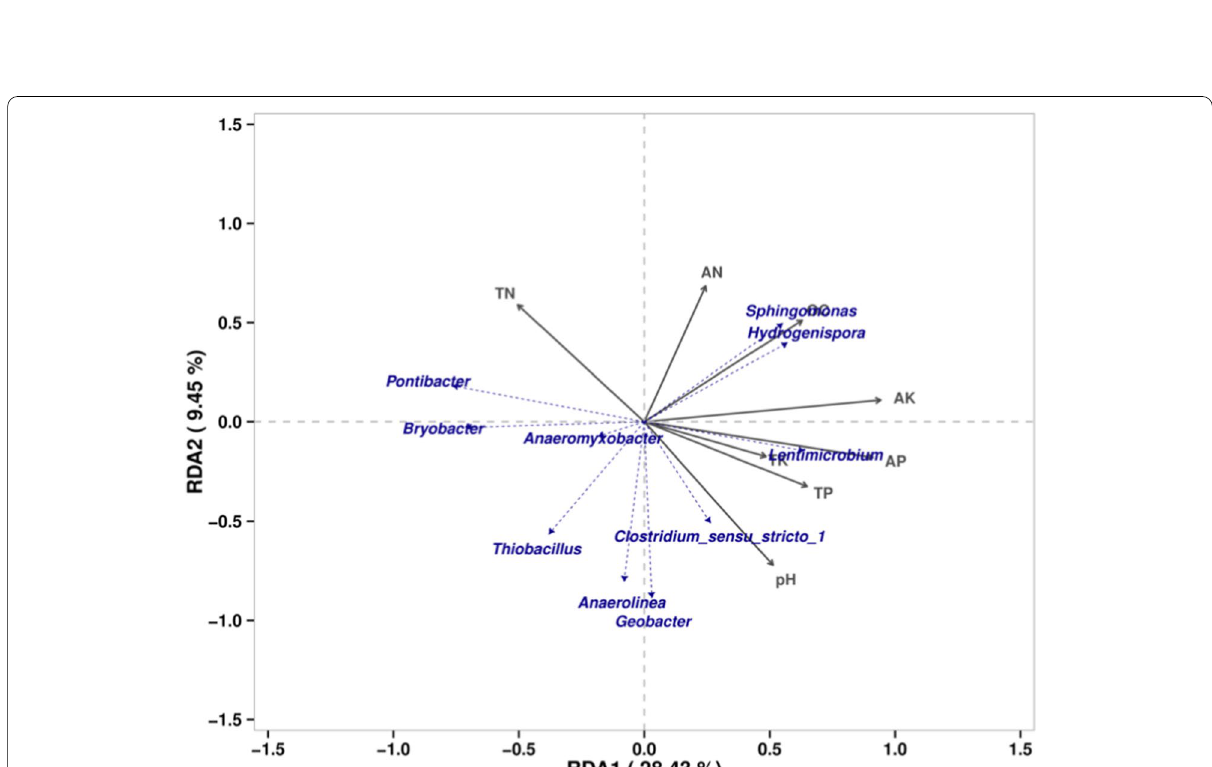
Fig. 4 Redundancy analysis of bacteria communities and environmental factors of soil. TP, total phosphorus; AK, available potassium; OC, organic matter; AN, available nitrogen; TN, total nitrogen; TK, total potassium; AP, available